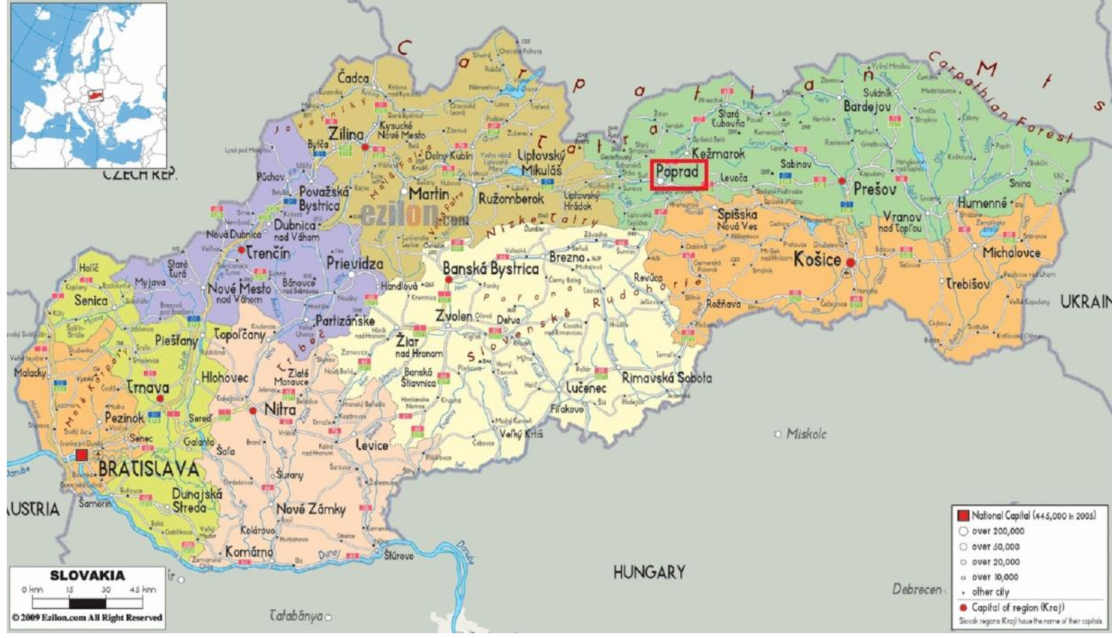
Figure 1. Slovakia, showing the city of Poprad (red rectangle) Source: Slovakia-Central Europe (2016)